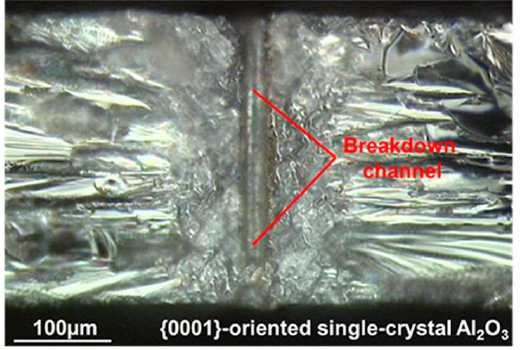
Figure 8. Breakdown channel in a single-crystal Al2O3 [59] .